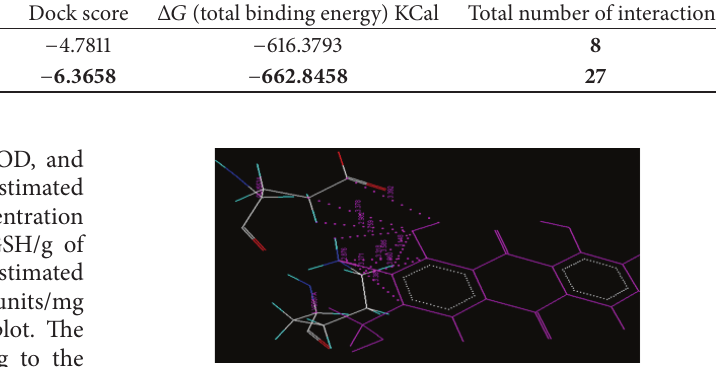
Figure 1: Van der Waals interaction of AE with protein 4COX.